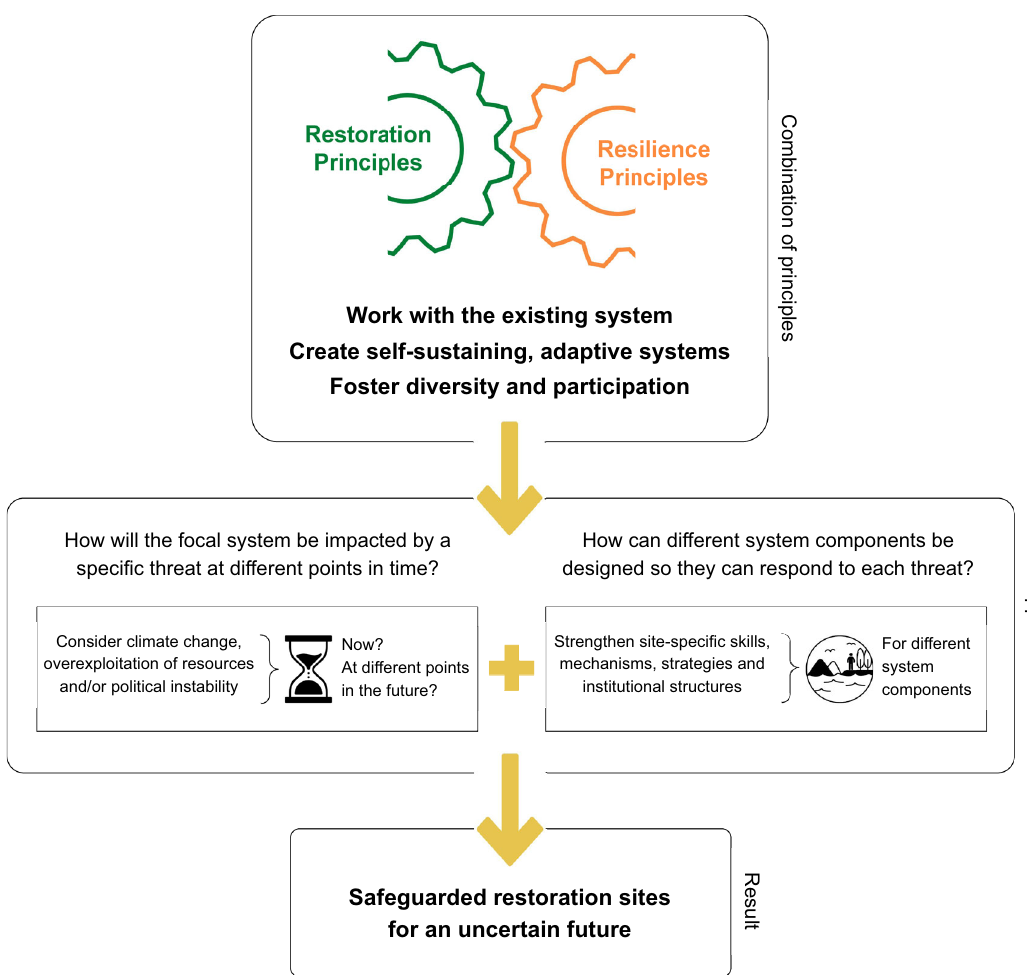
Fig. 2 Safeguarding restoration sites by integrating restoration and resilience principles. Three high-level guiding themes for future-proof restoration practice were derived from the synthesis of 52 existing restoration and resilience principles (see Table 1). These guiding principles can be applied to restoration projects to facilitate the development of site-speci fi c skills, mechanisms, strategies, and institutional structures that enhance the restoration system ’ s adaptive